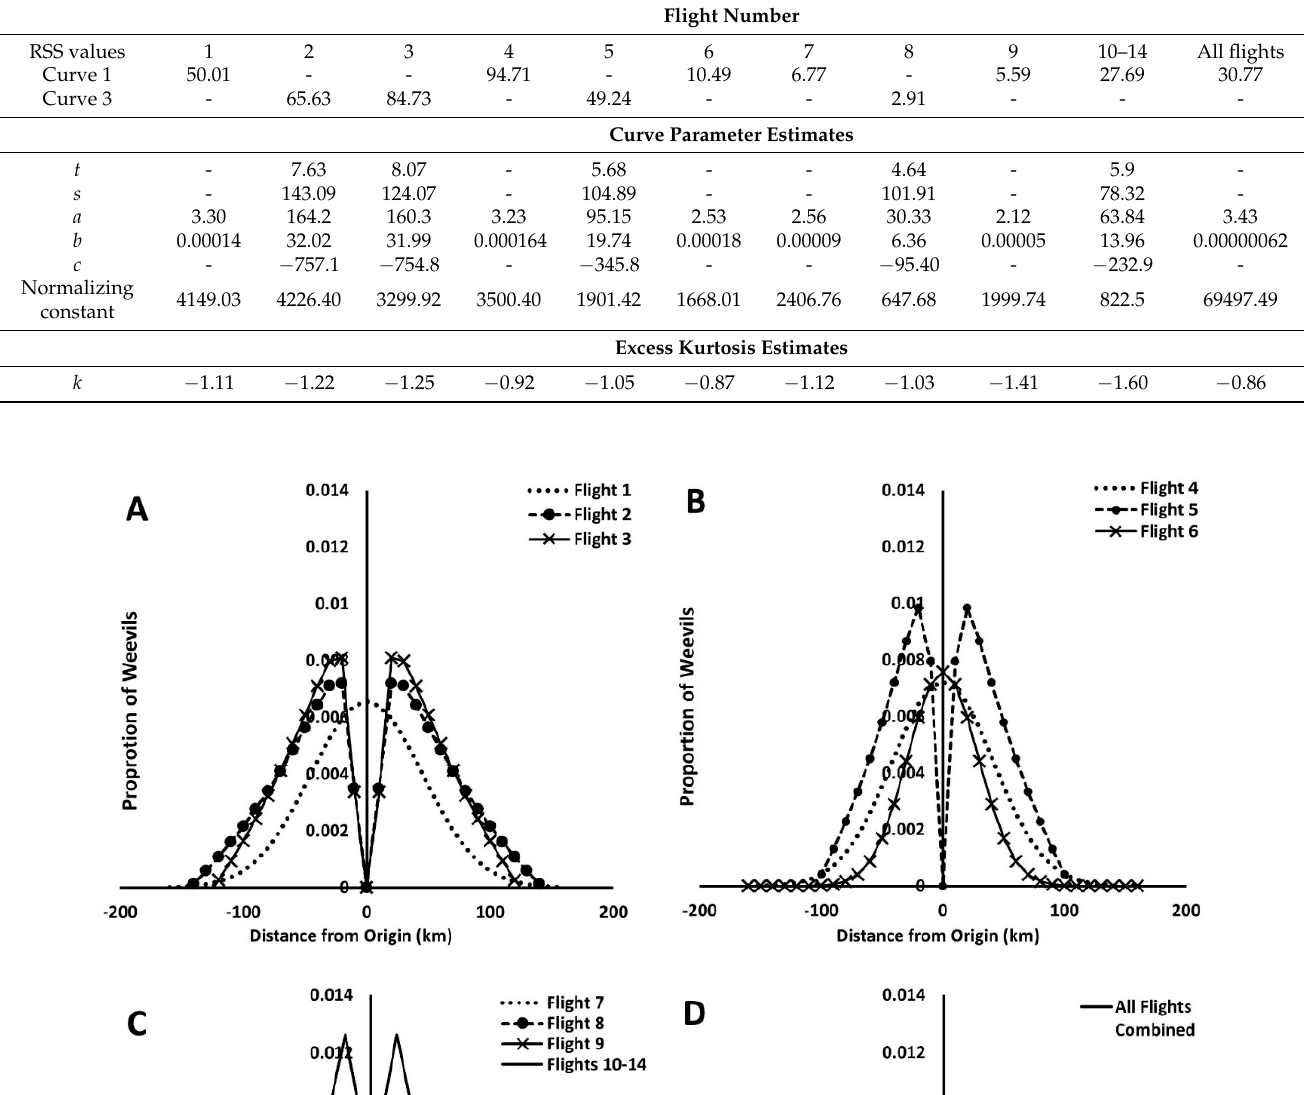
Table 2. Lowest calculated RSS values fitted to equations for curves 1 and 3 from Kot et al. [1], parameter estimates and normalizing constants for curves 1 and 3, and measures of excess kurtosis for individual flights 1–9, combined flights 10–14, and all flights combined (1–14).